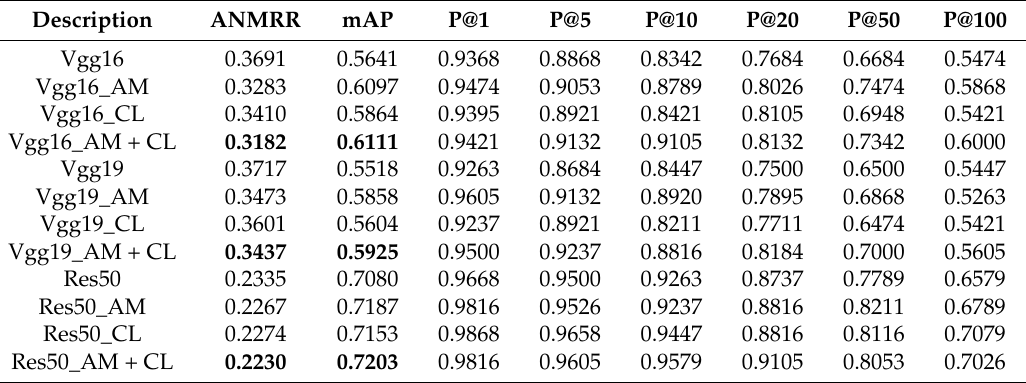
Table 6. Comparisons of three different schemes with the baseline networks. The best result for each baseline CNN (Convolutional Neural Network) is reported in